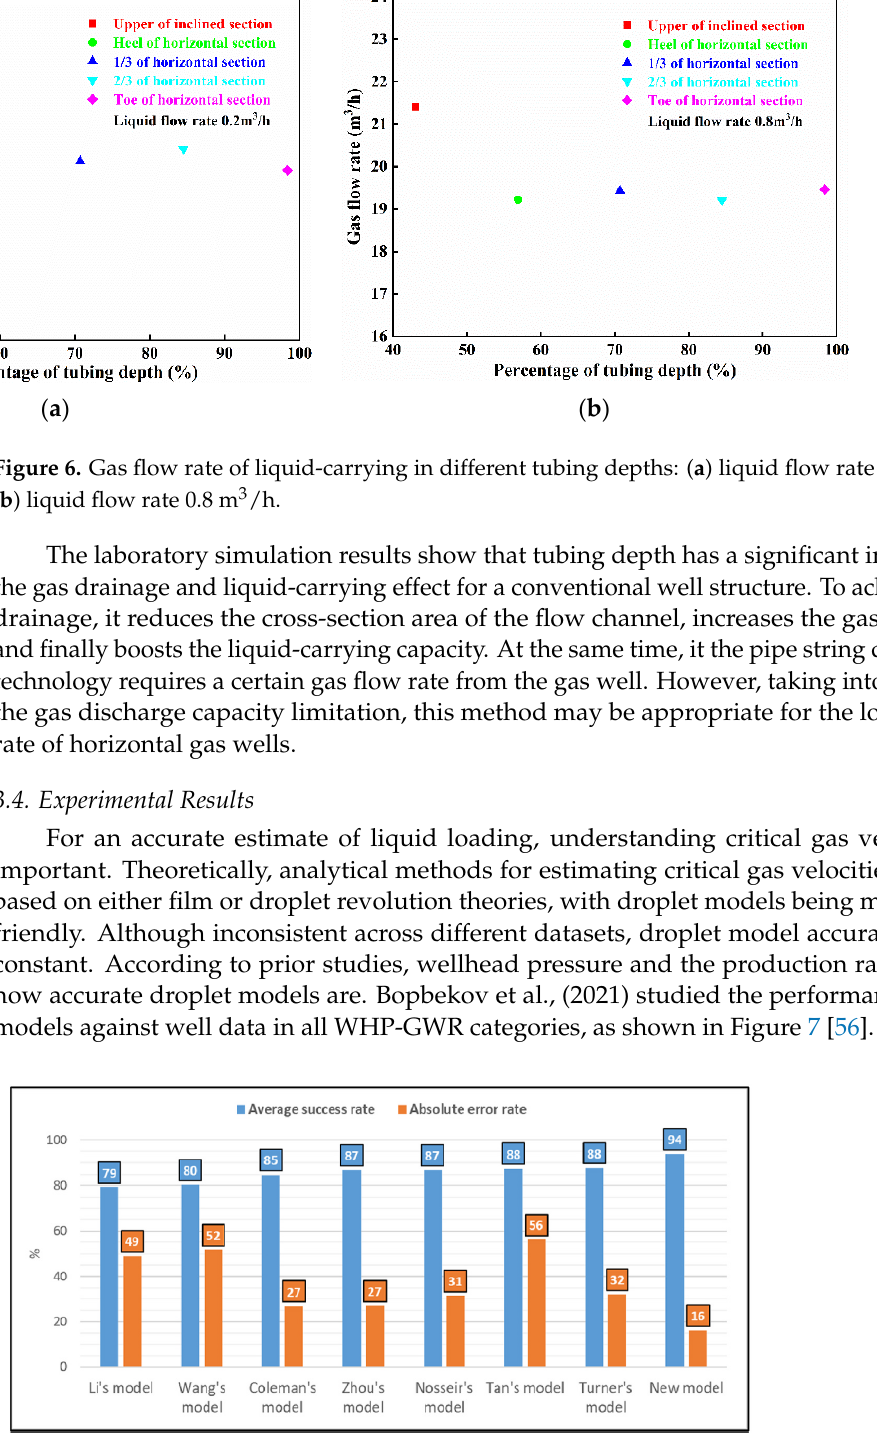
Figure 7. Performance of all models against well data in all WHP ‐ GWR categories